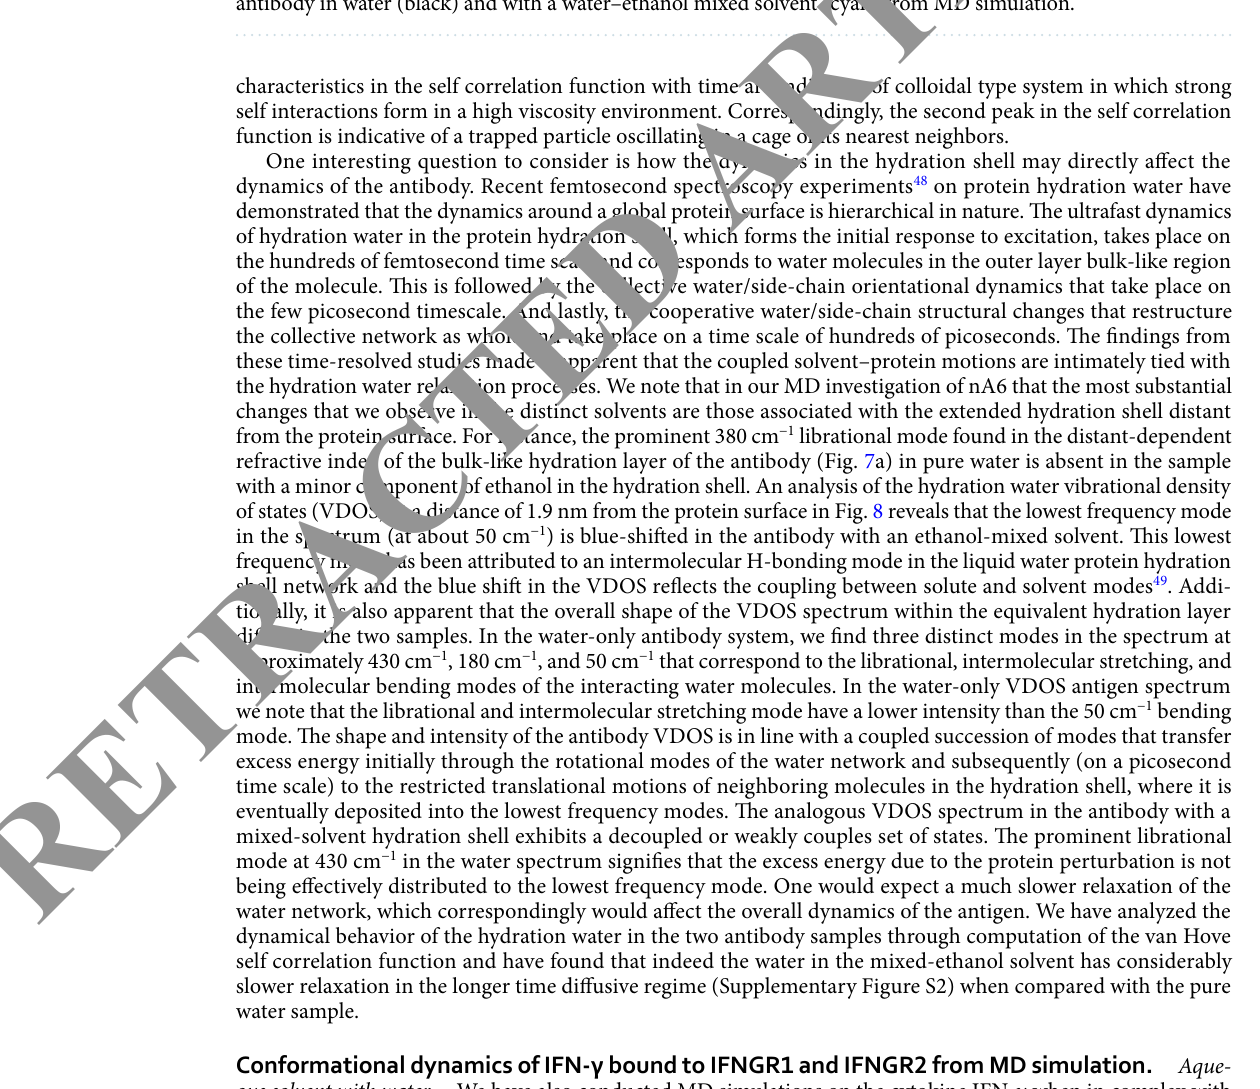
Figure 8. The calculated vibrational density of states (VDOS) of water molecules in the hydration shell of the antibody in water (black) and with a water–ethanol mixed solvent (cyan) from MD